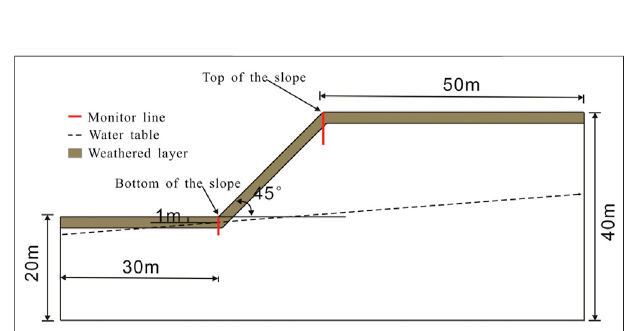
FIGURE 4 | Schematic diagram of program development for non- intrusive stochastic method.